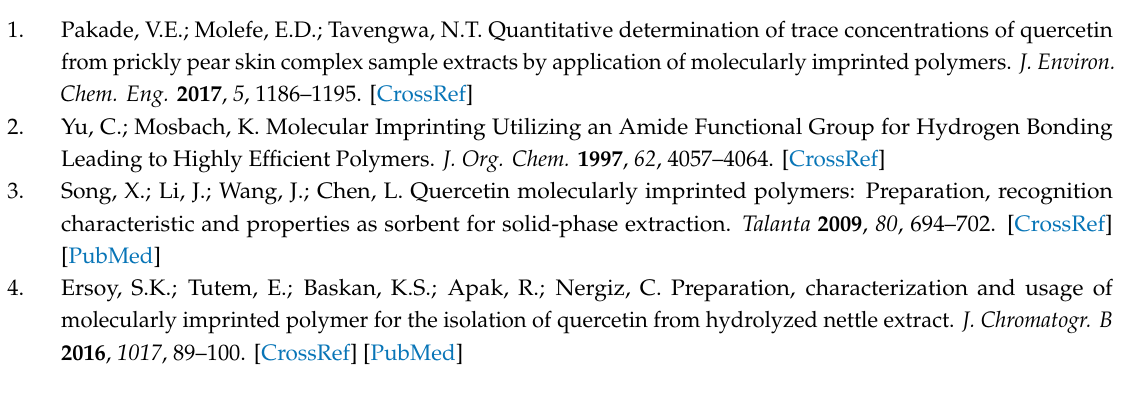
Supplementary Materials: The following are available online, Figure S1: The steps for the preparation of molecularly imprinted polymer (MIP). Figure S2: General steps for the preparation of magnetic molecularly imprinted polymer (mag-MIP). Figure S3: The FTIR spectra of NIP (a) and Q-MIP (b). Figure S4: The FTIR spectra of mag-NIP (a) and Q-mag-MIP (b). Figure S5: SEM images of the Q-MIP (a,b); MIP (c,d); NIP (e,f). Figure S6: SEM images of Q-mag-MIP (a,b); mag-MIP (c,d); mag-NIP (e,f). Figure S7: ESI spectrum of quercetin in the range of positive ions ( m / z 303 [M + H] + and 325 [M + Na] + ). Figure S8: ESI spectrum of quercetin in the range of the range of positive ion ( m / z 303 [M + H] + ). Figure S10: ESI fragmentation spectrum of quercetin in the range ions. Figure S12: Fragmentation pathways of quercetin in the range of negative ions. Figure S13: Intensity of the positive signal at m / z 303 versus quercetin concentration in solution